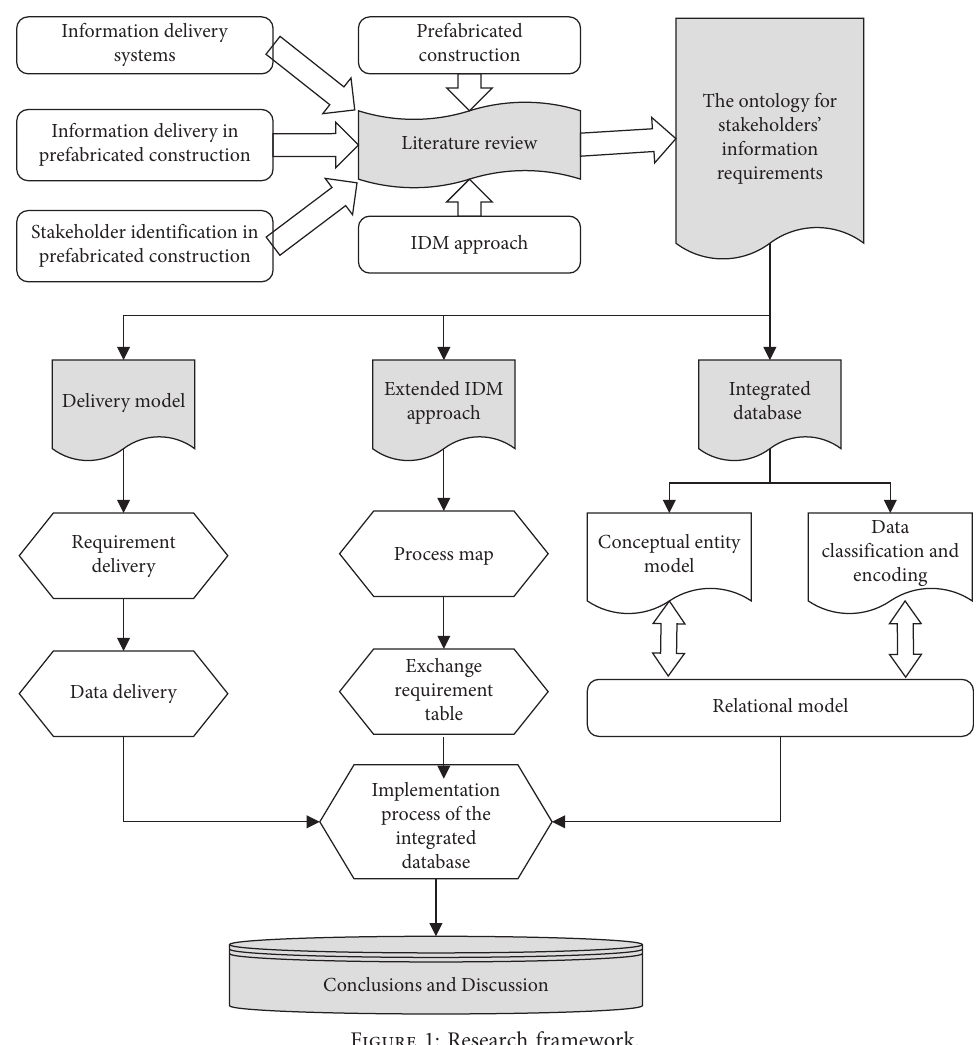
Figure 1: Research framework.